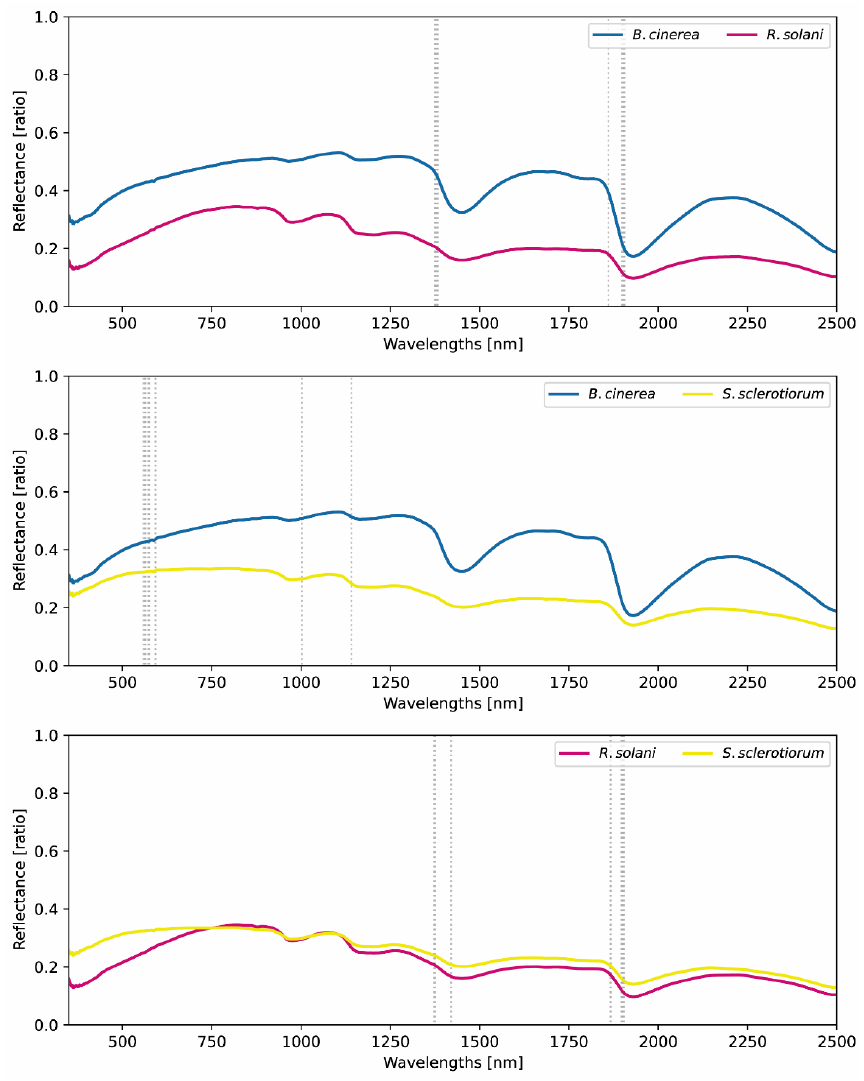
Figure 4. Comparison of the spectra of three fungi species. The 10 wavelengths most useful for distinguishing the three fungi species are marked by dashed vertical lines.